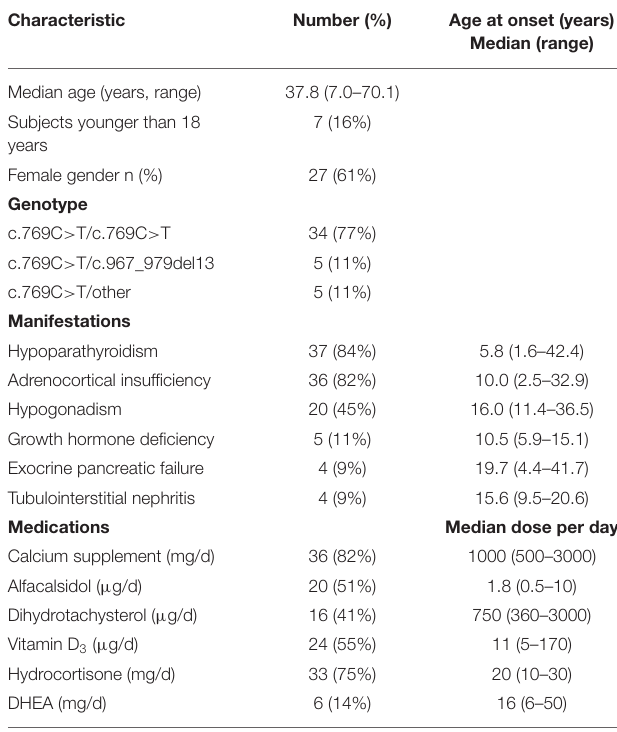
TABLE 1 | Characteristics of the 44 Finnish patients with